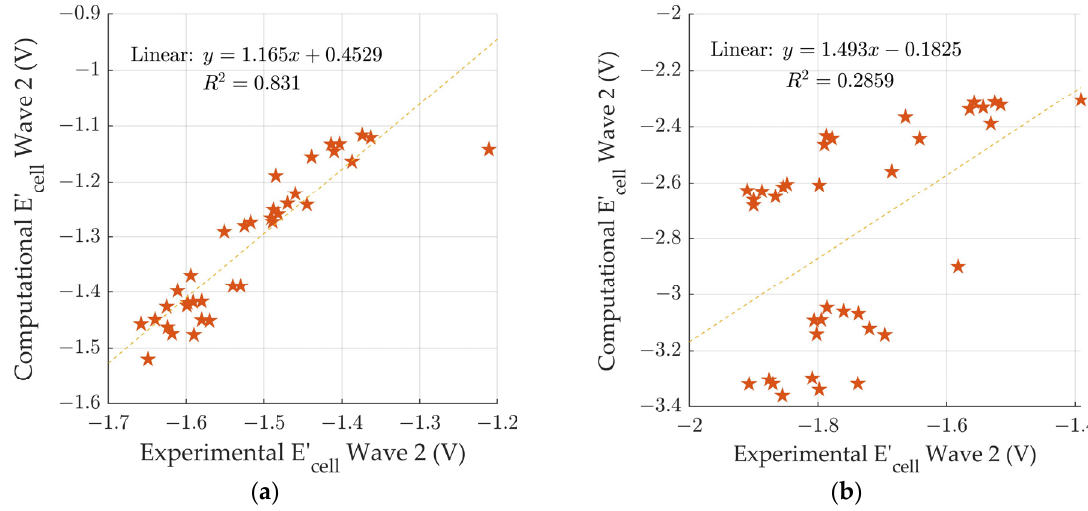
Figure 4. Comparison of computational electrochemical cell potentials vs. experimental electro- chemical cell potentials [18] for ( a ) wave 1, and ( b ) wave 2. ical cell potentials [18] for ( a ) wave 1, and ( b ) wave